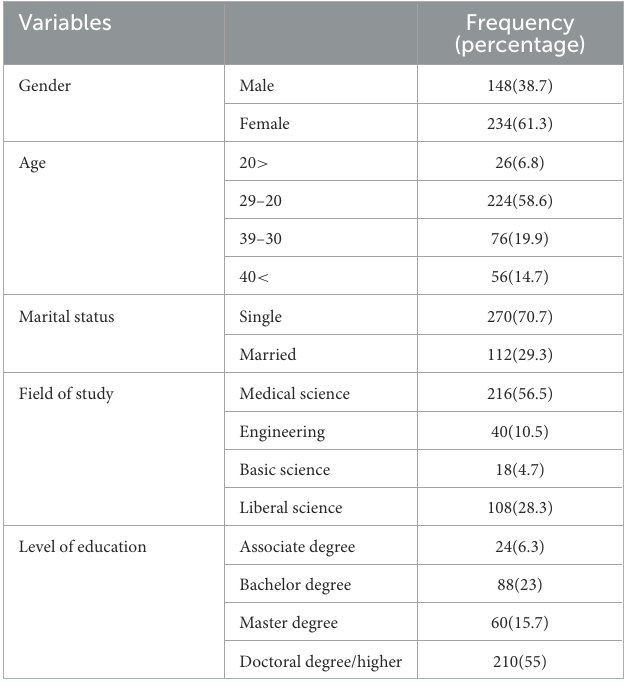
TABLE 1 Demographic features of the students of Tehran